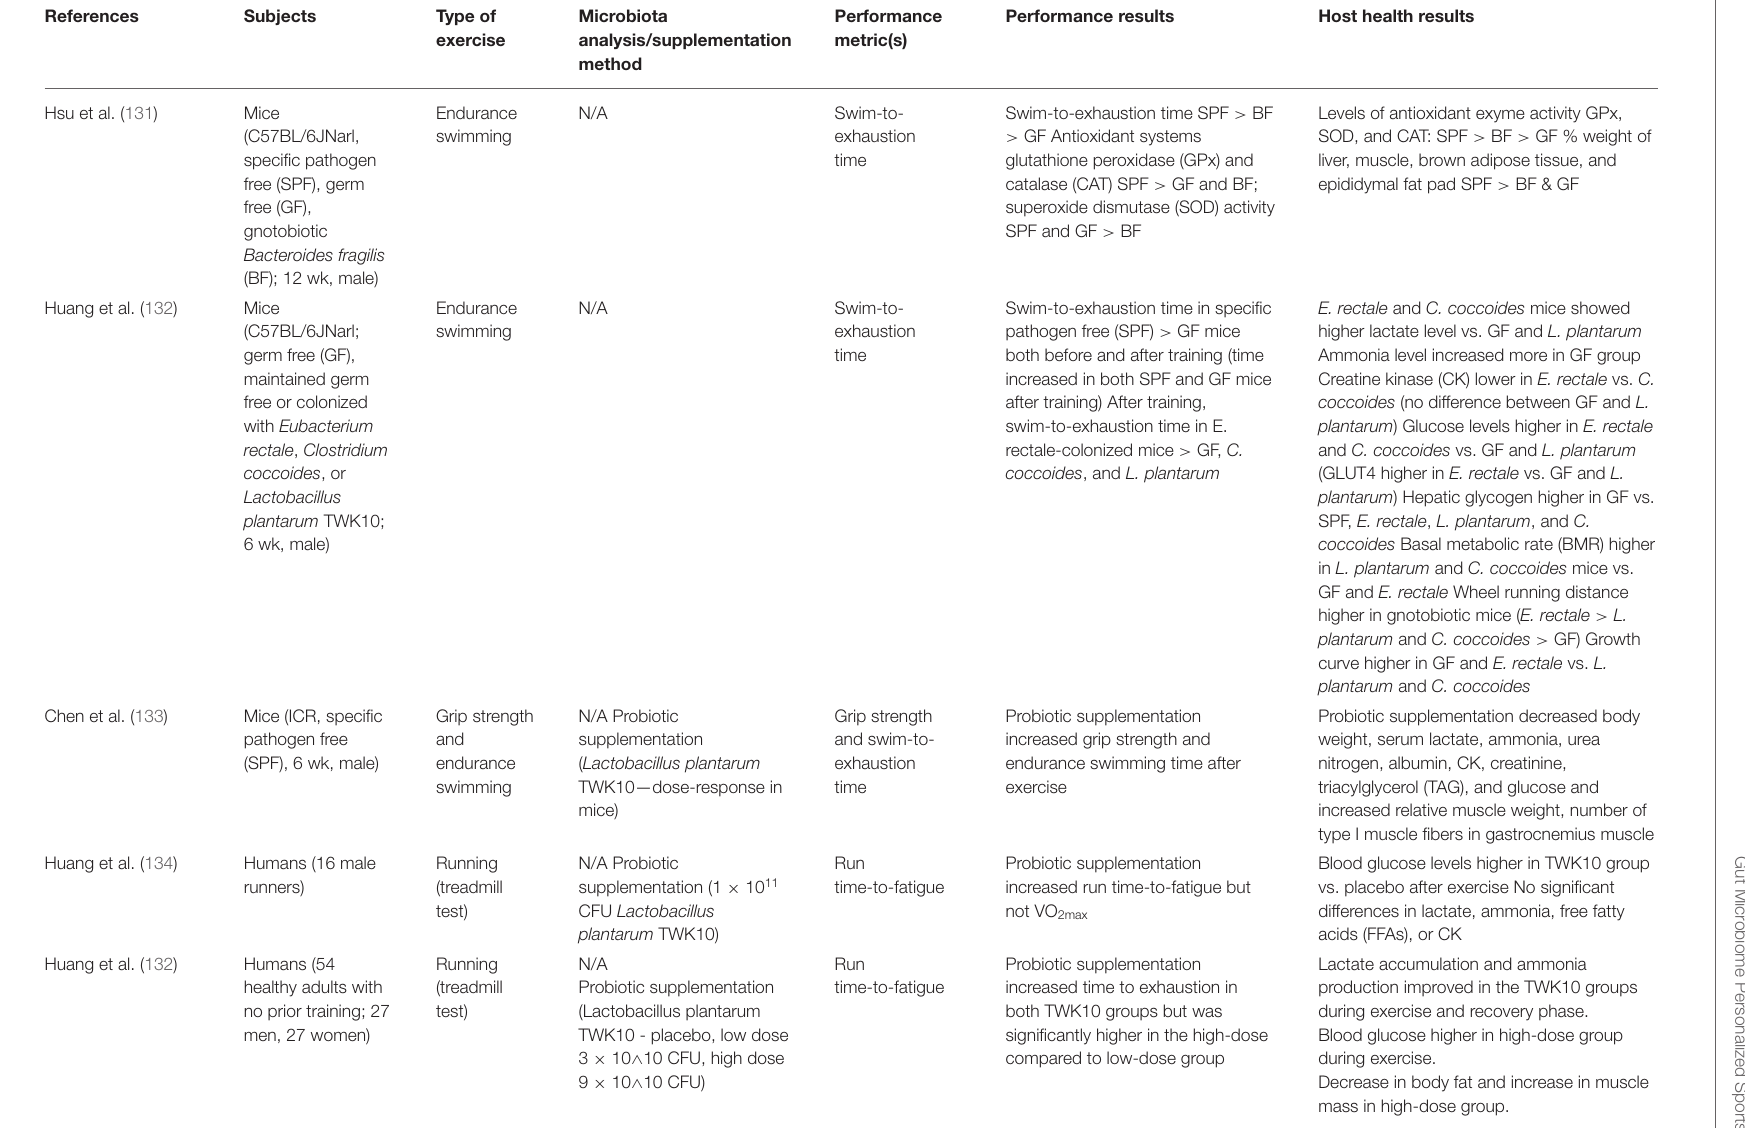
TABLE 4 | Summary of studies investigating the effect of the gut microbiota or probiotic supplementation on exercise